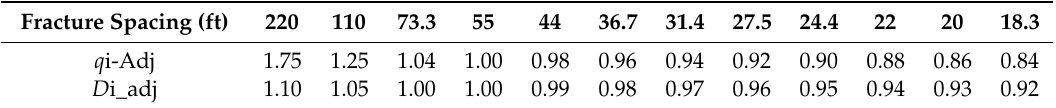
Figure 9. Flow-cell model adjustment factors for use in the wet gas window when fracture spacing varies between 220 and 18.3 ft. ( a ) q i_adj and ( b ) D i_adj . The data points are the empirical values used to snugly fit flow-cell forecasts with ResFrac simulator forecasts. The linear and natural logarithmic regression curves give R-squared of 99% and 98%, respectively. Table 4. Flow-cell model adjustment factors q i_adj and D i_adj . for use in the wet gas window when fracture spacing varies between 220 and 18.3 ft.